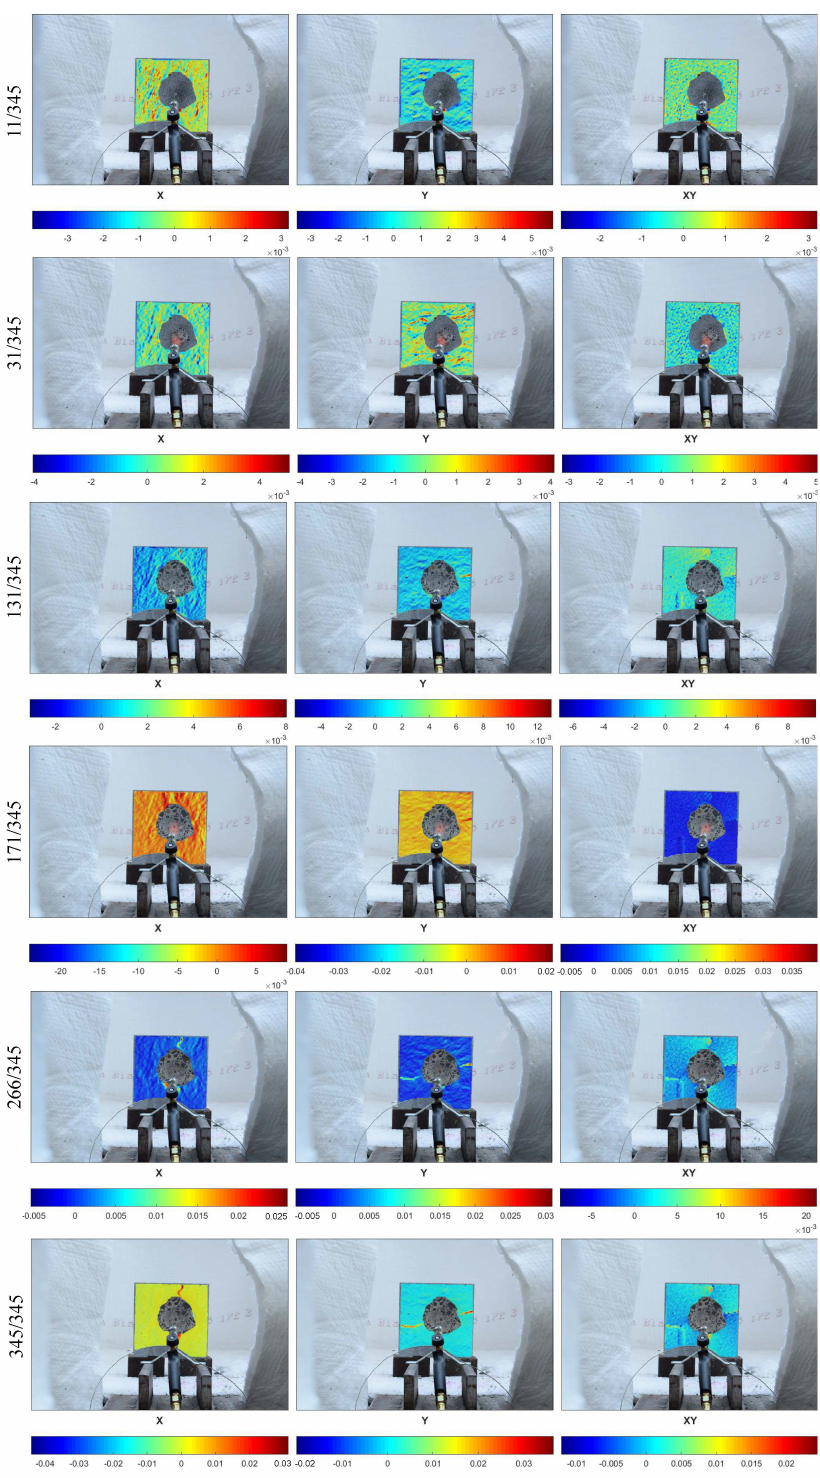
Figure 8. Deformation fields in the x- and y-directions for the medium specimen (200 × 200